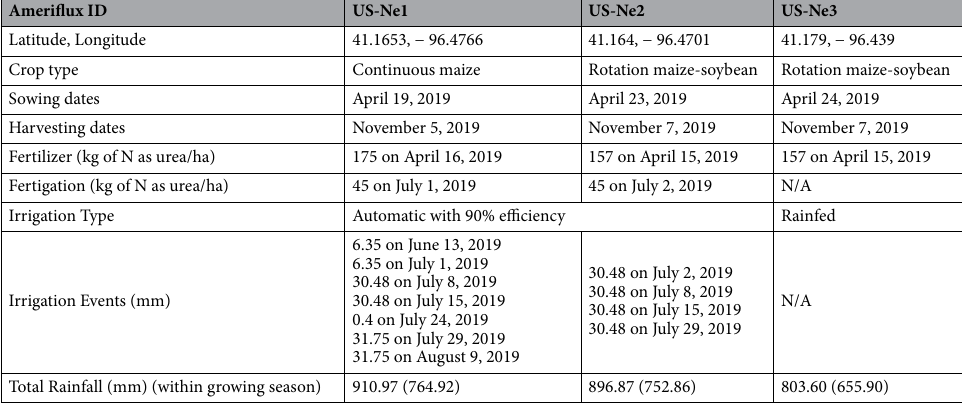
Table 1. Description of each study site, including the location, crop type, total rainfall, irrigation and fertilizer applications. These data are based on management logs taken during the course of the growing